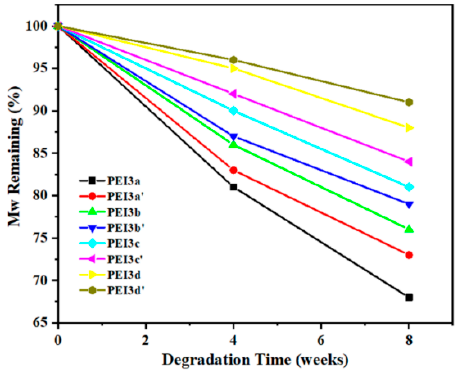
Table 5. Weight average molecular (M w × 10 4 ) of PEI3a–PEI3d ′ at every stage of biodegradation.